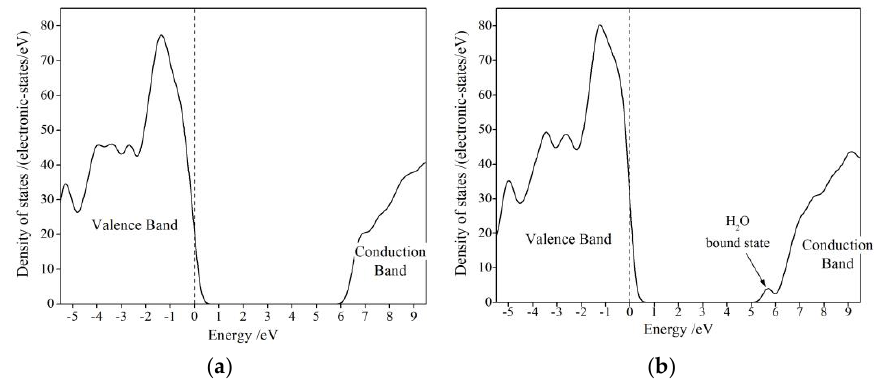
Figure 7. Density of state for ( a ) pure transformer oil and ( b ) oil-water system in local region model.